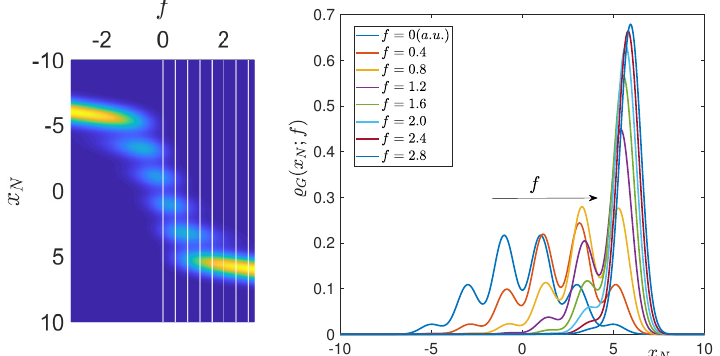
-10 -5 Figure 6. Examples of multimodal curves obtained through the Gibbs density (cid:36) G ( x N ; f ) (see Equation (33)). On the left panel, the two-dimensional representation of the Gibbs density is shown with the cuts corresponding to the curves plotted on the right panel. We used N = 5, (cid:96) = 1 (a.u.), k = 15 (a.u.), k B T = 1 (a.u.) and different values of the applied force f , as indicated in the legend.